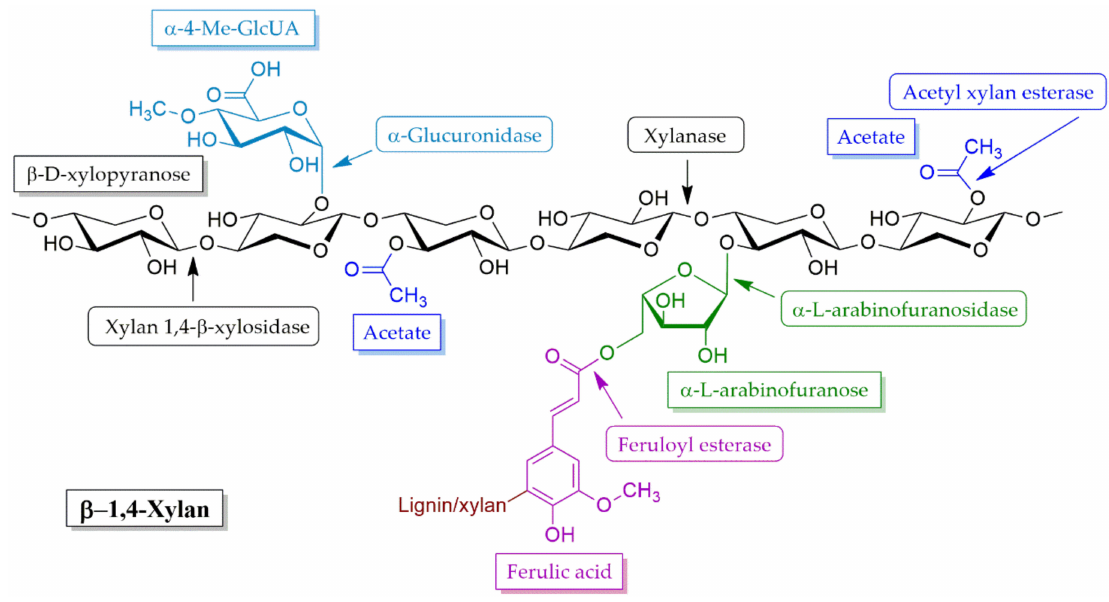
Figure 6. Enzymes involved in xylan